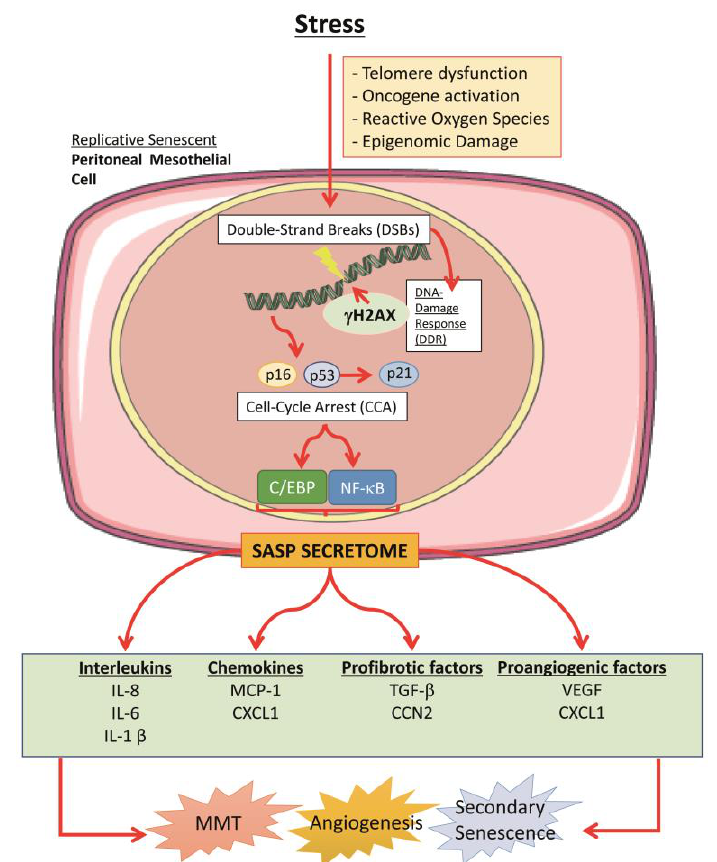
Figure 2. Cellular senescence is triggered by different kinds of stimuli, some resulting in Double- Strand breaks (DSBs). This activates the DNA-Damage Response (DDR), in which γ H2AX may repair the DNA. However, prolonged damage leads to Cell-Cycle Arrest (CCA) due to p16, p53, and p21 upregulation. Then, the cell gene expression is reprogramed, starting to release the senescence- associated secretory phenotype (SASP), mainly regulated by C/EBP (CCAT/Enhancer Binding Protein) and NF- κ B (nuclear factor- κ B), and enriched with numerous factors such as interleukins, chemokines, profibrotic and proangiogenic mediators. These metabolic changes can contribute to several pathological processes in the peritoneal cavity, such as Mesothelial-to-Mesenchymal transition (MMT), angiogenesis, and secondary senescence, or spreading cellular senescence to neighboring cells.